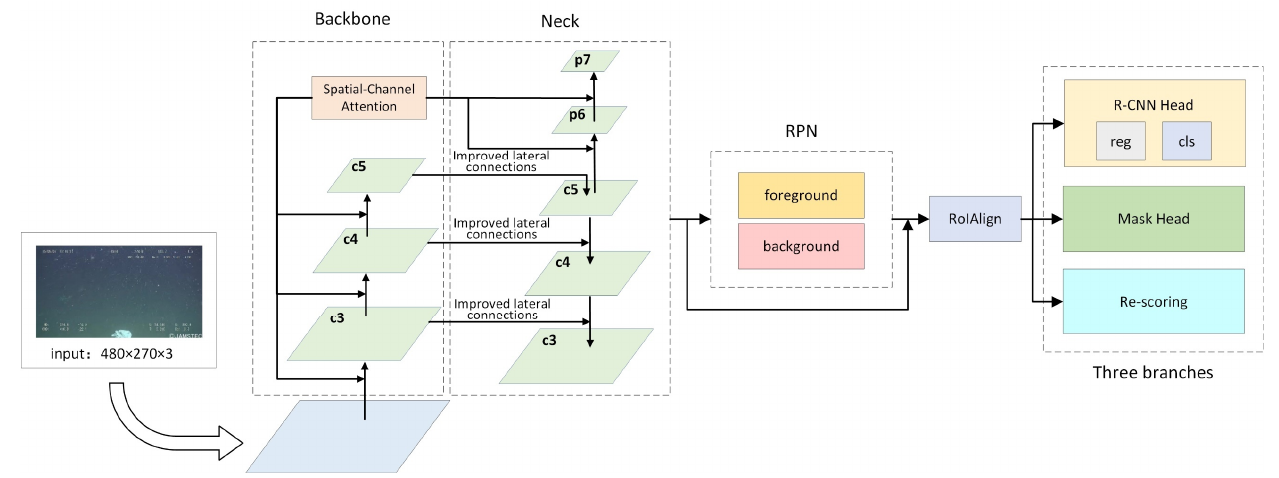
Figure 6. The overall structure of the proposed method in this paper